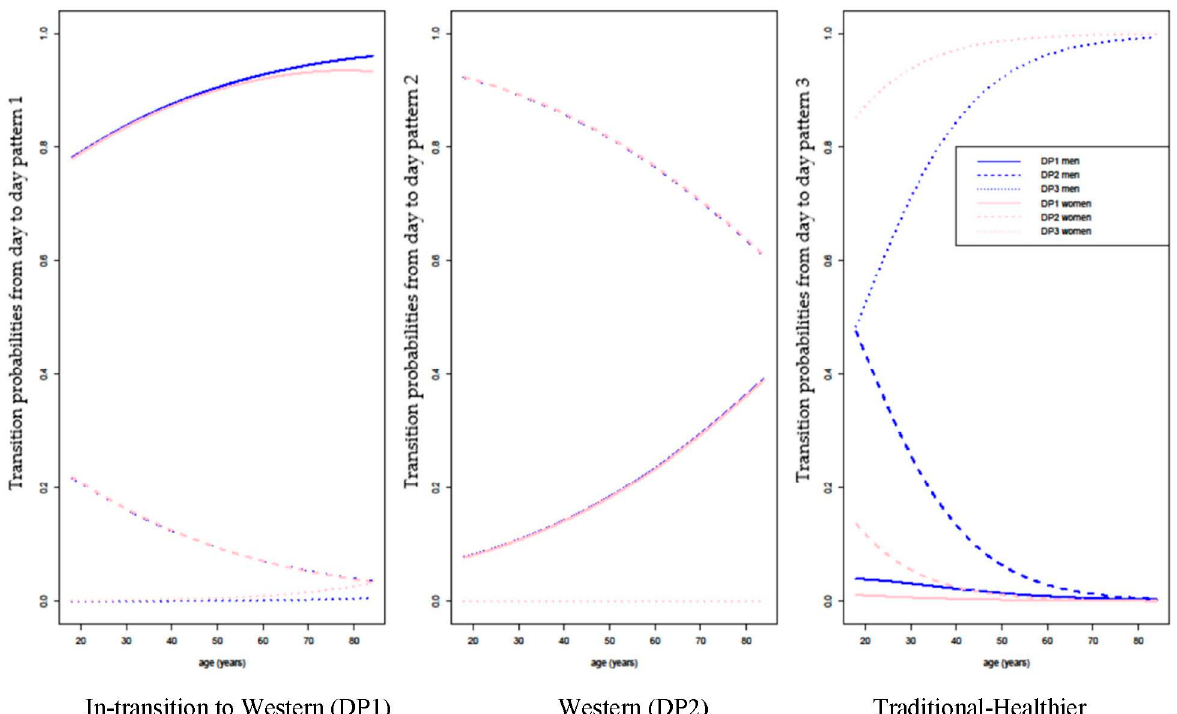
Figure 2. Transitional probabilities by age and sex based on the estimated model (latent transition model) for each dietary pattern. DP: dietary pattern.